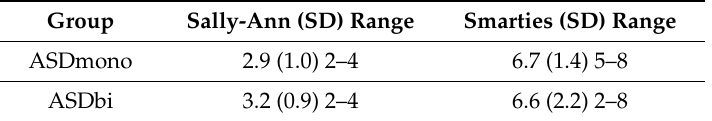
Table 8. Groups’ mean accuracy scores in the verbal theory of mind tasks. Group